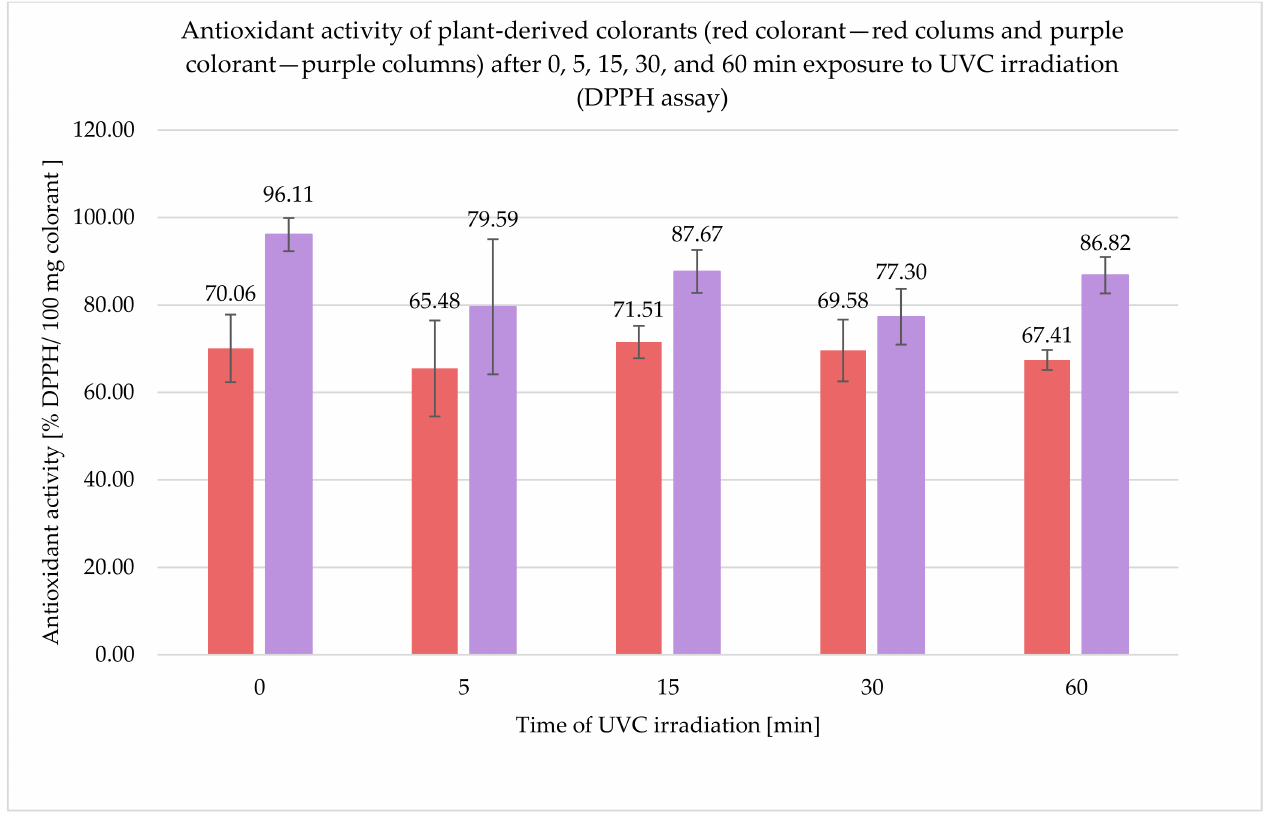
Figure 2. Results of antioxidant activity of plant-derived colorants (red and purple) after 0, 5, 15, 30, and 60 min exposure to UVC irradiation (DPPH